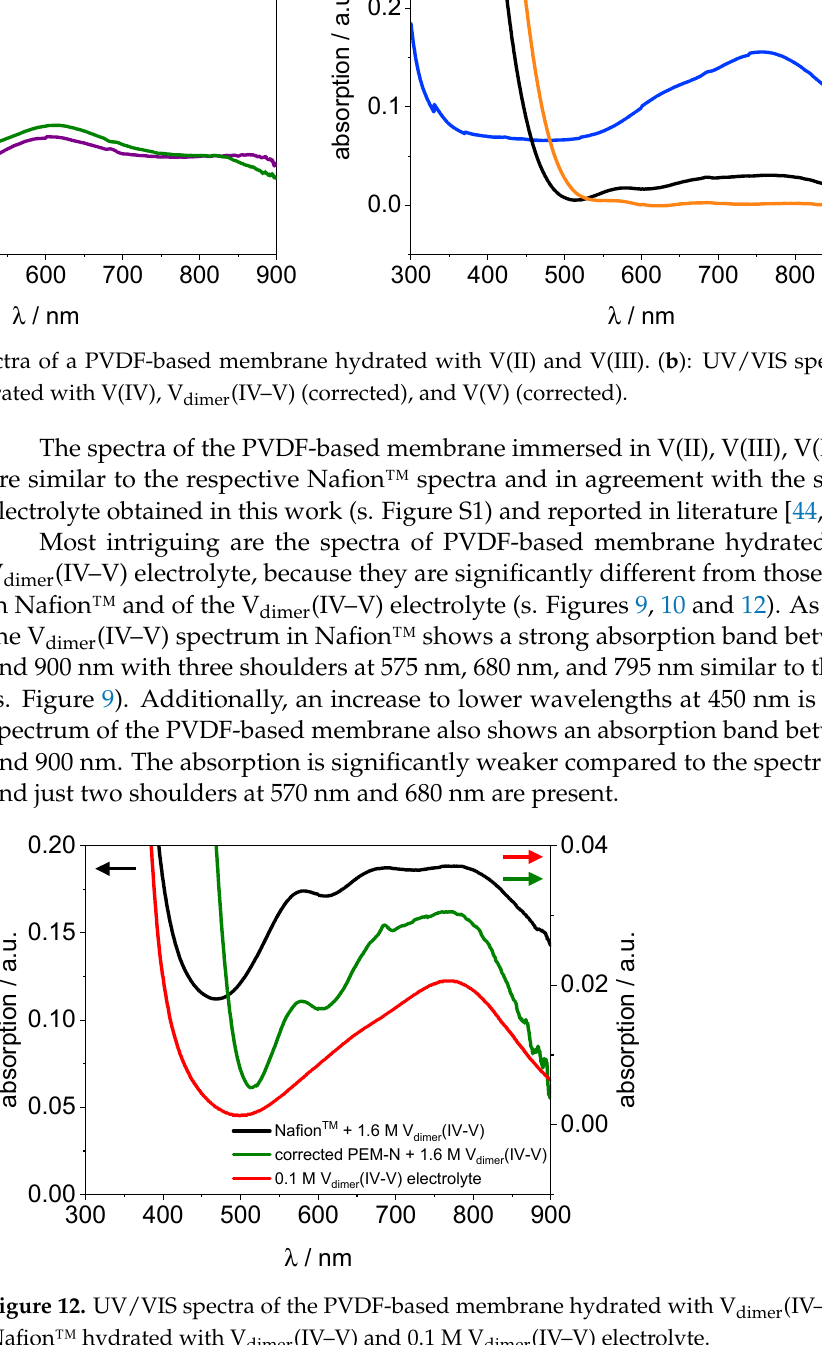
Figure 10. UV/VIS spectra of Nafion™ hydrated with V dimer (IV–V) and 1.6 M V dimer (IV–V) electrolyte.